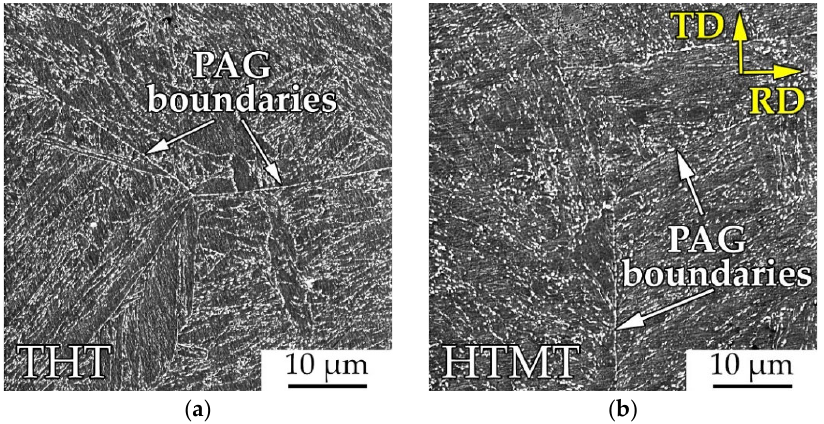
Figure 4. SEM SE (secondary electrons) images of the etched surface of EK ‐ 181 steel samples after THT ( a ) and HTMT in a section parallel to the rolling plane ( b ).